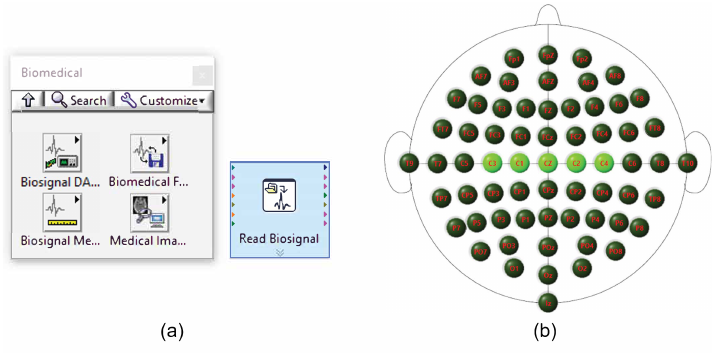
Figure 4. Selected electrodes for EEG signal classification. ( a ) Biomedical toolkit and ( b ) electrodes selected.